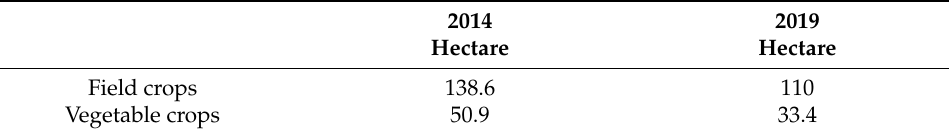
Table 1. Cultivated area in Jordan